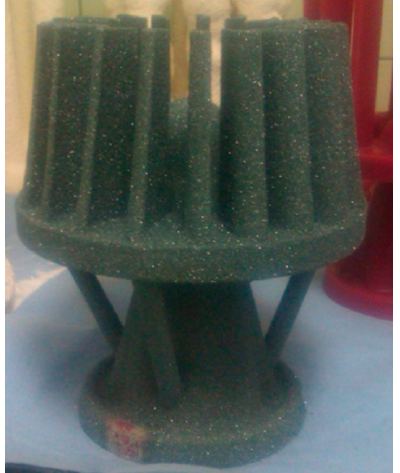
Figure 3. Example SiC mould (raw state) obtained using Imerys W440 binder.